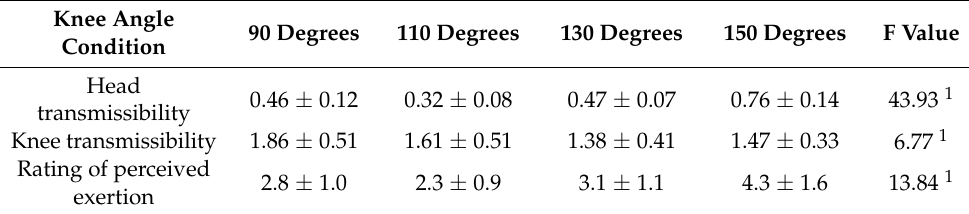
Table 1. Comparison of the head transmissibility, knee transmissibility, and rating of perceived exertion among knee angle